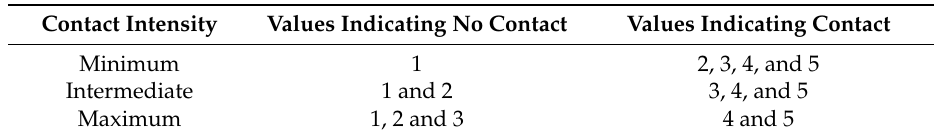
Table 1. Dichotomization by contact